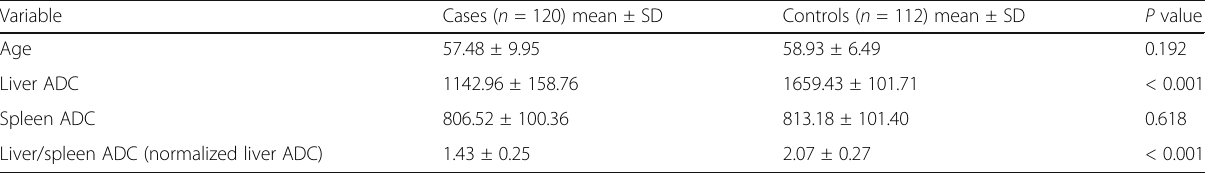
Table 1 Age and different ADC measurements between cases and control group Variable